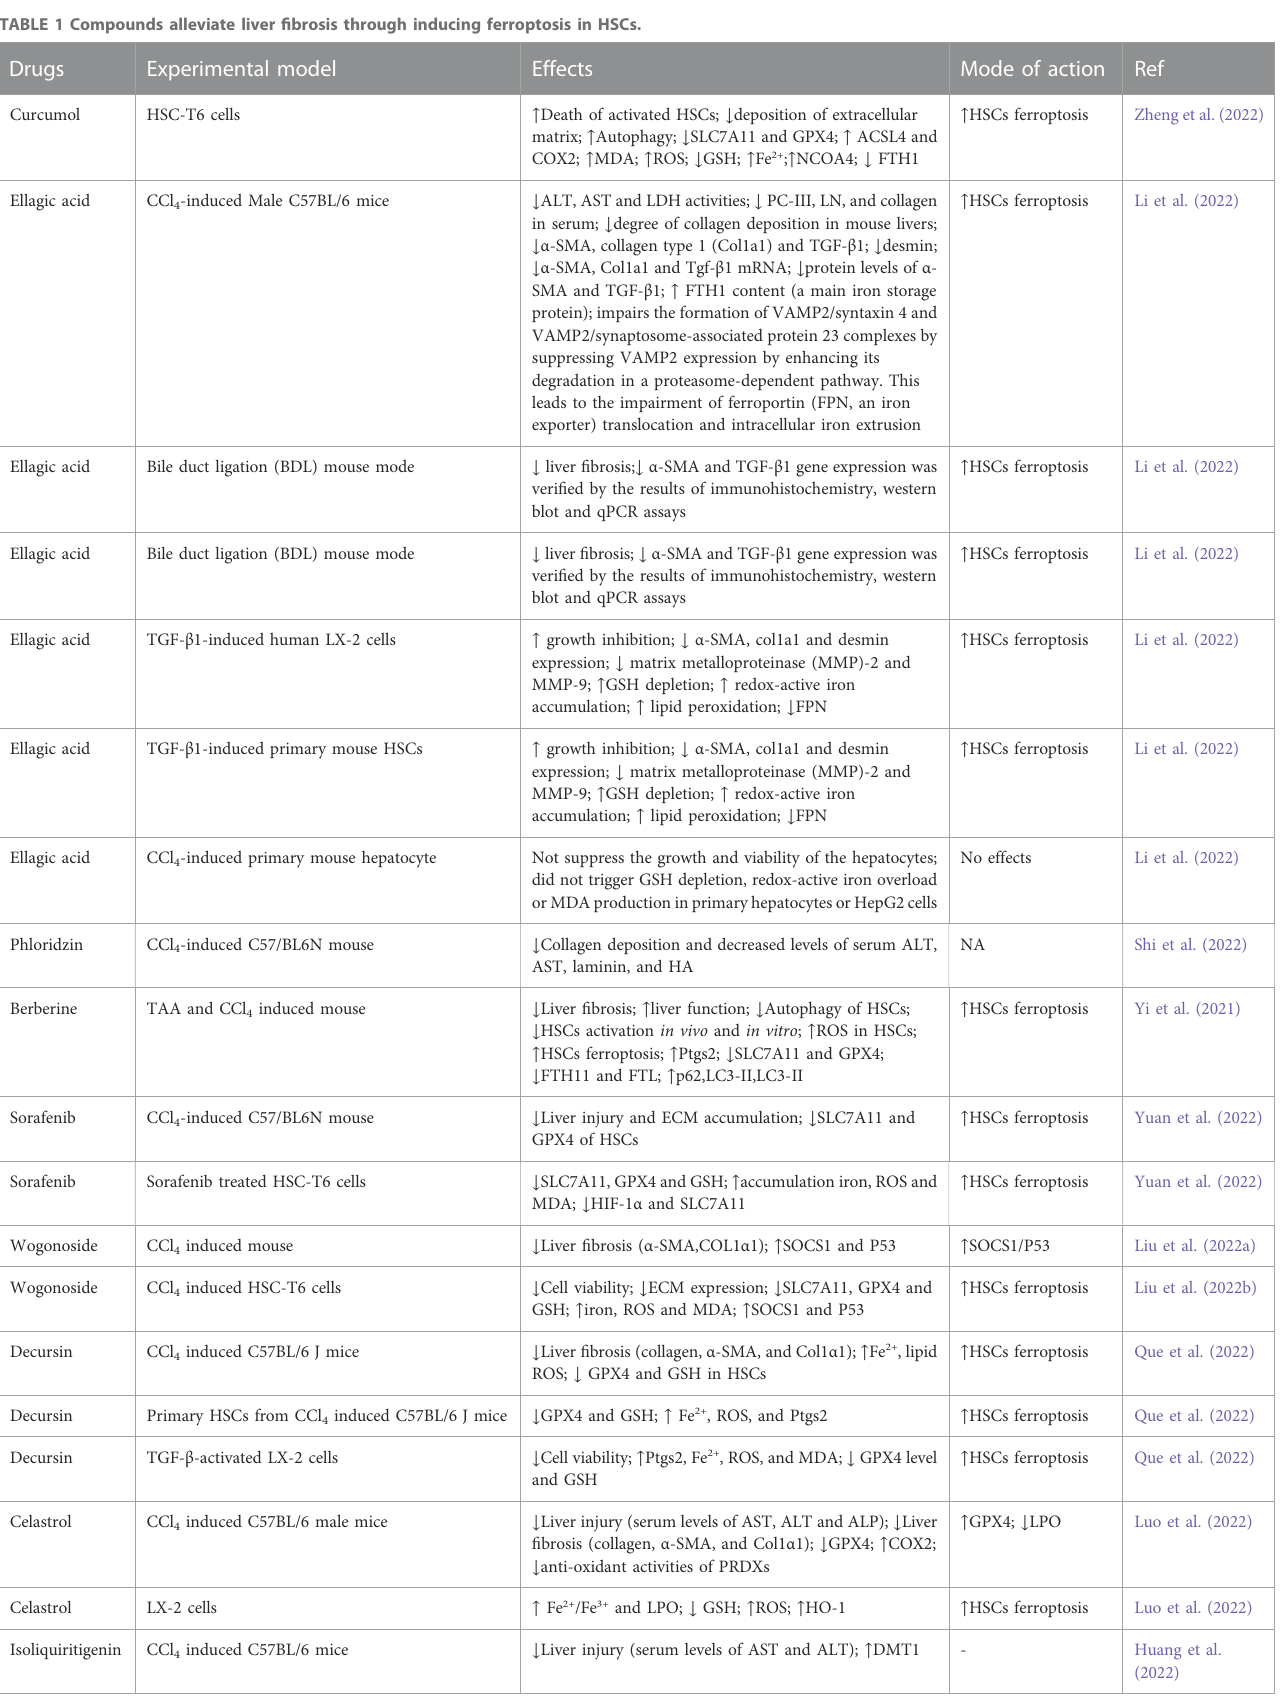
TABLE 1 Compounds alleviate liver fi brosis through inducing ferroptosis in